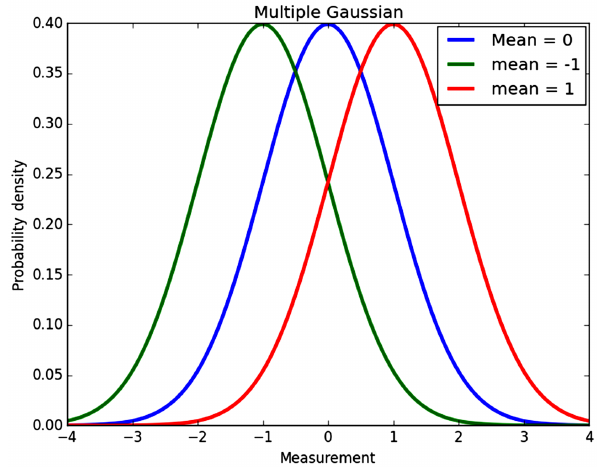
Figure 2. An example of three fitted normal